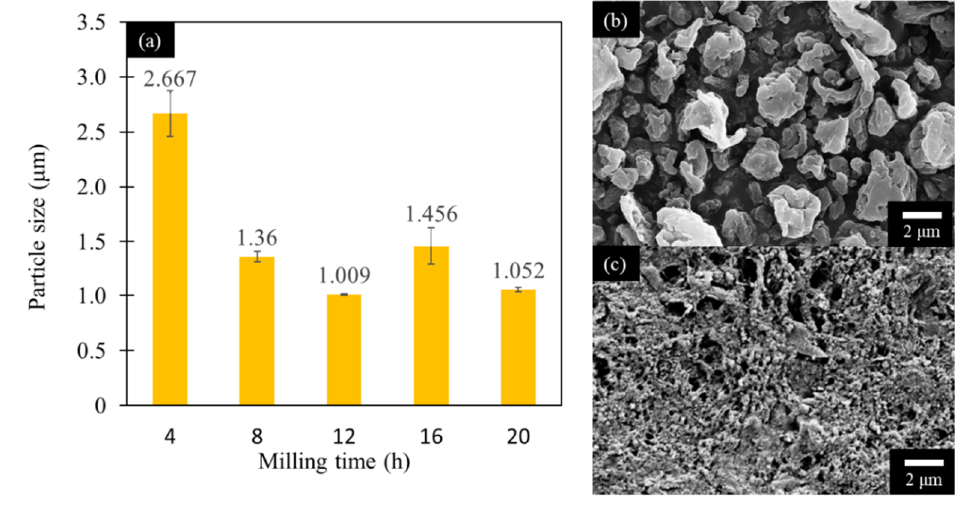
Figure 1. ( a ) Particle size as a function of wet milling time; scanning electron microscope (SEM) images of hemp particles: ( b ) after 4 h and ( c ) after 20 h of wet